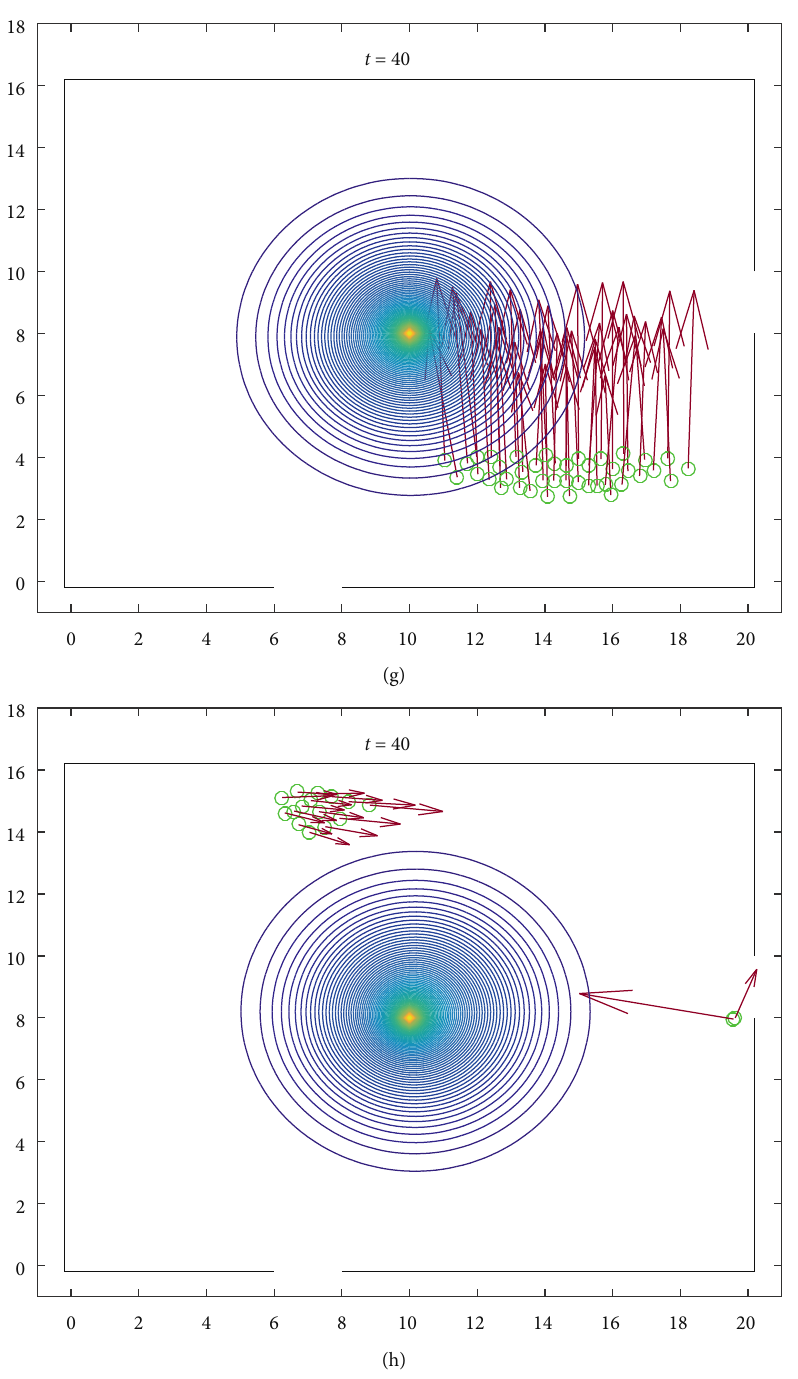
Figure 12: Movements of 200 pedestrians during smoke spreading in the case that there are no guider and 5% guiders in simulation. The smoke source is in the middle of the room. The entire time period of a simulation is 50 s. The simulation room consists of two exits as Figure 3(b). (a) no guider, t = 0 s. (b) 5% guiders, t = 0 s. (c) no guider, t = 5 s. (d) 5% guiders, t = 5 s. (e) no guider, t = 20 s. (f) 5% guiders, t = 20 s. (g) no guider, t = 40 s. (h) 5% guiders, t = 40